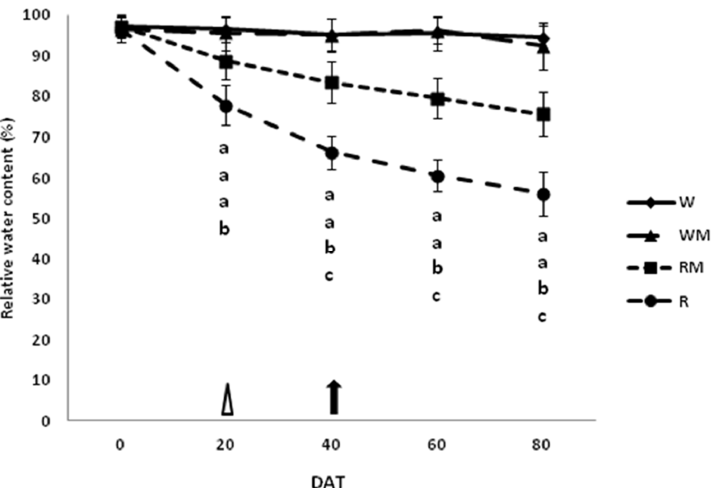
Figure 6. Changes in relative water content (%) of spearmint exposed to the following treatments: R—rainfed without straw mulch, RM—rainfed with straw mulch, W—well-watered control plants and WM—well-watered with straw mulch. Measurements were performed 0, 20, 40, 60 and 80 days after the onset of the treatments (DAT). Vertical bars represent ± SE of the mean ( n = 5). Bars with different letters indicate significant differences among treatments in the given DAT at p ≤ 0.05. Triangle at 20 DAT indicates the early bloom, and arrow at 40 DAT indicates the full bloom, in overall treatments.